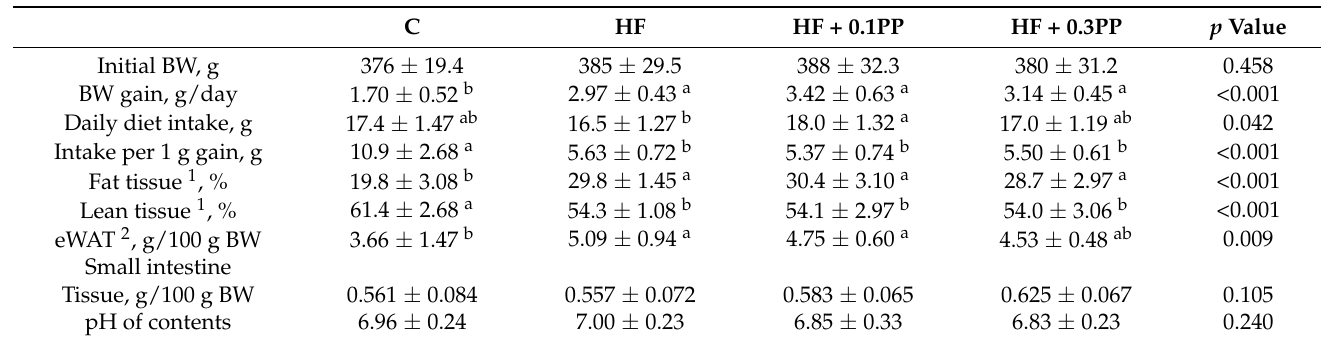
Table 3. Growth parameters and dietary intake of the rats fed experimental diets and nuclear magnetic resonance (NMR) analysis of selected tissues.